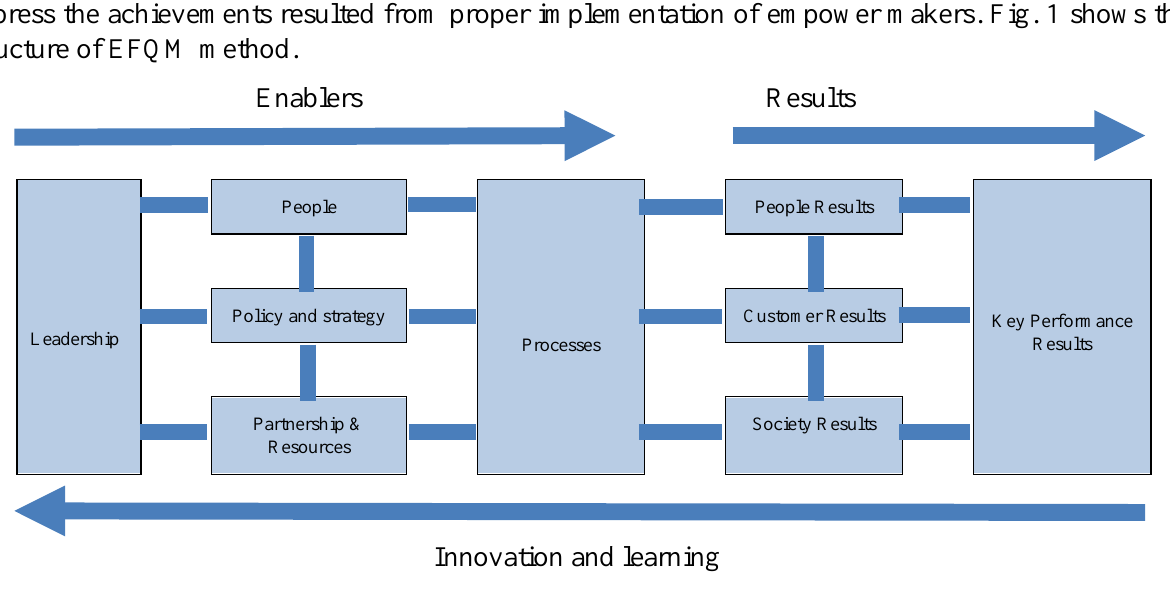
Fig. 1. EFQM transcendent